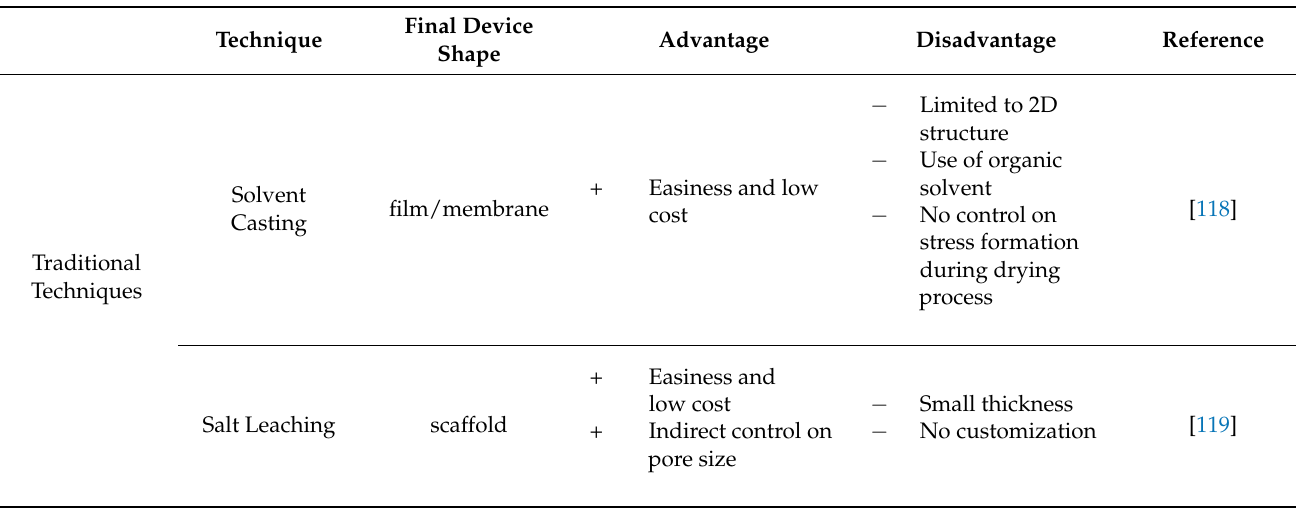
Table 1. Outline and comparison of the traditional and additive manufacturing (AM) techniques used to produce medical devices from PHA.